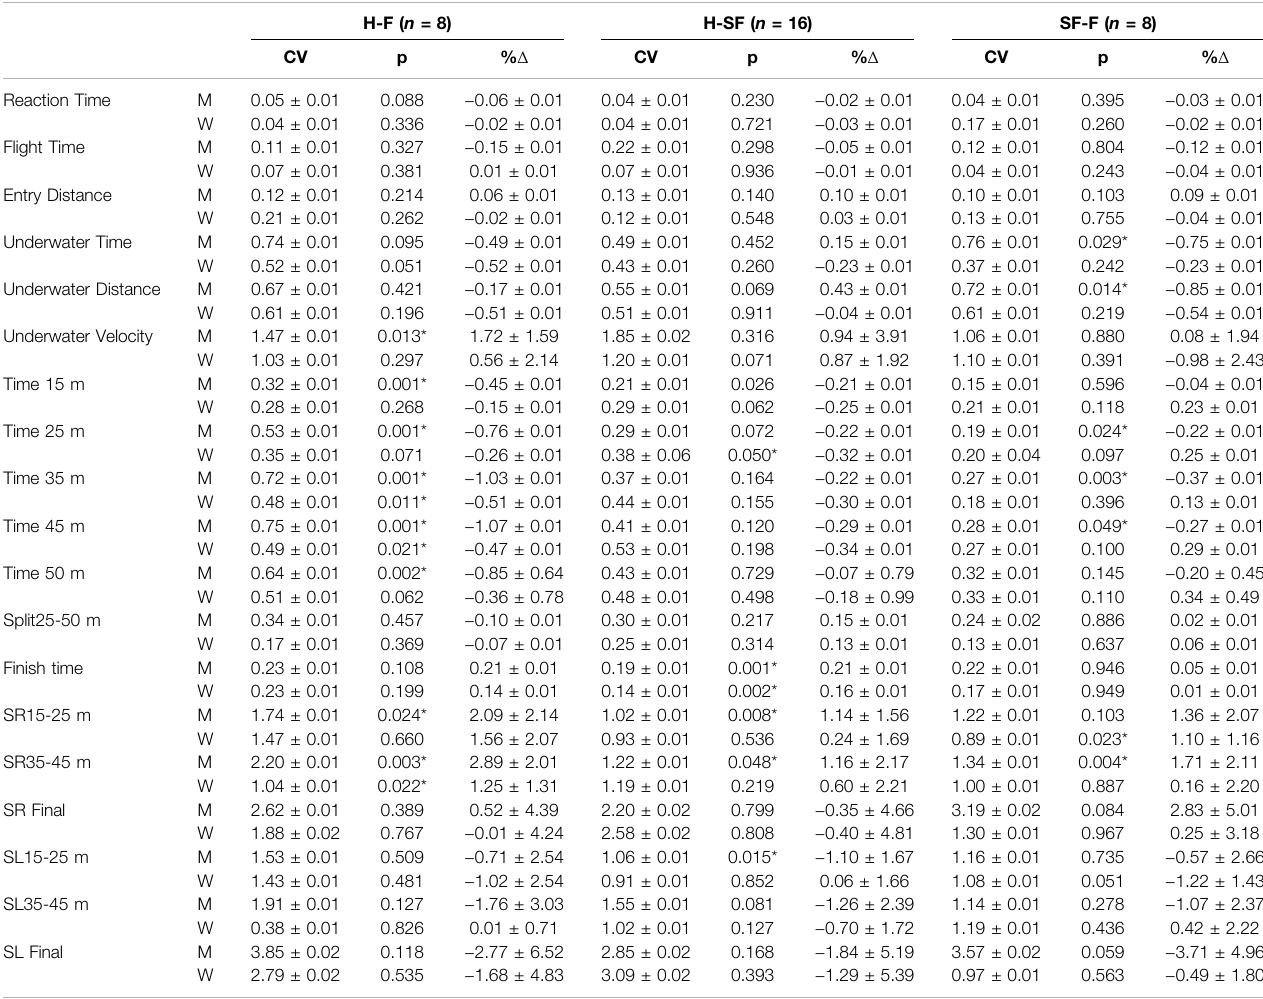
TABLE 6 | Backstroke intra-athlete ’ s coef fi cient of variation (CV) and relative change in performance (% Δ ). Men (M); Women (W); Heat (H); Semi- fi nal (SF); Final (F) (LEN European Senior Championships